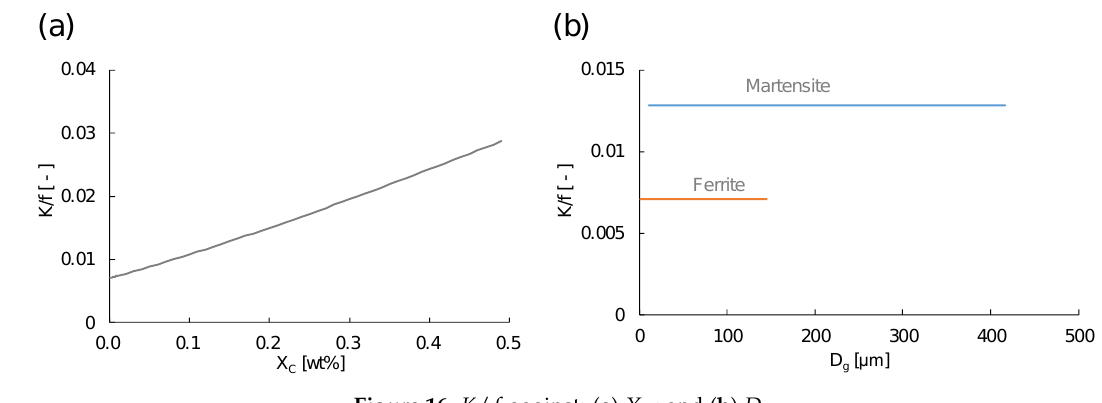
Figure 16. K / f against: ( a ) X C ; and ( b ) D g